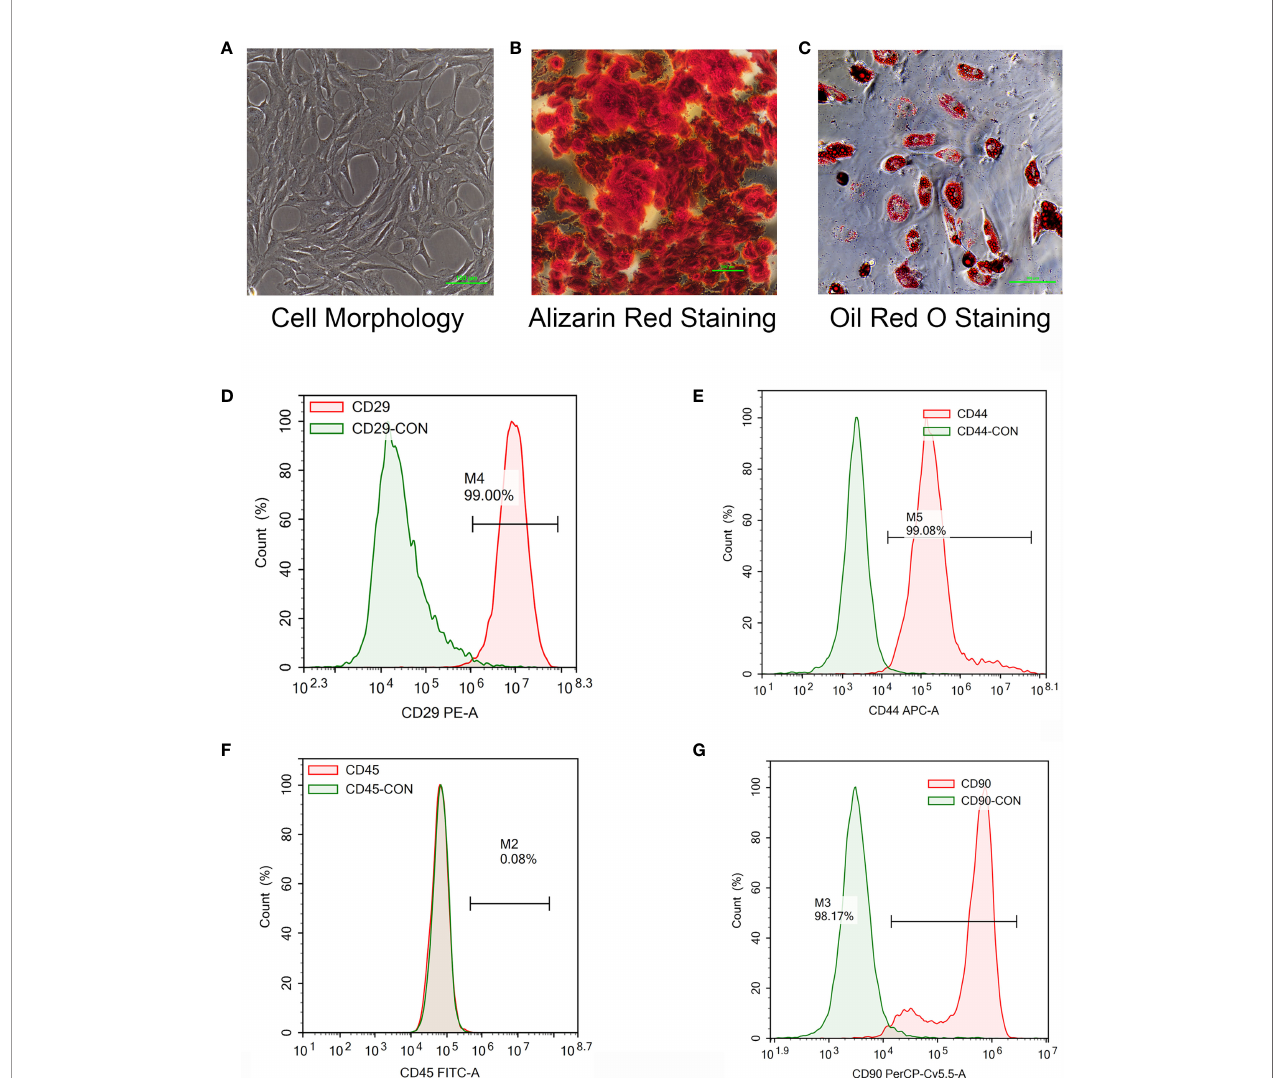
FIGURE 9 | Isolation and culture of rat primary BMSCs, the induction of osteogenic and adipogenic differentiation and the detection of cell surface markers. (A) The morphology of primary BMSCs from third-generation rats was observed under a microscope (×40). (B) After the osteogenic differentiation of third-generation BMSCs was induced with an osteogenic differentiation-inducing agent (Alizarin red staining), the formation of mineralized nodules was observed under a microscope (×100). (C) The adipogenic differentiation of third-generation BMSCs was induced by an adipogenic differentiation-inducing agent, and lipid droplets were enlarged and made rounder by continuous culture with maintenance medium (stained with oil red O) and observed under a microscope (×200). (D – F) The primary BMSCs of third- generation rats were collected and stained for CD29 (D) , CD44 (E) , CD45 (F) and CD90 (G) for 30 min. Control staining was simultaneously carried out. Fluorescence was detected with a fl ow cytometer, and the results were